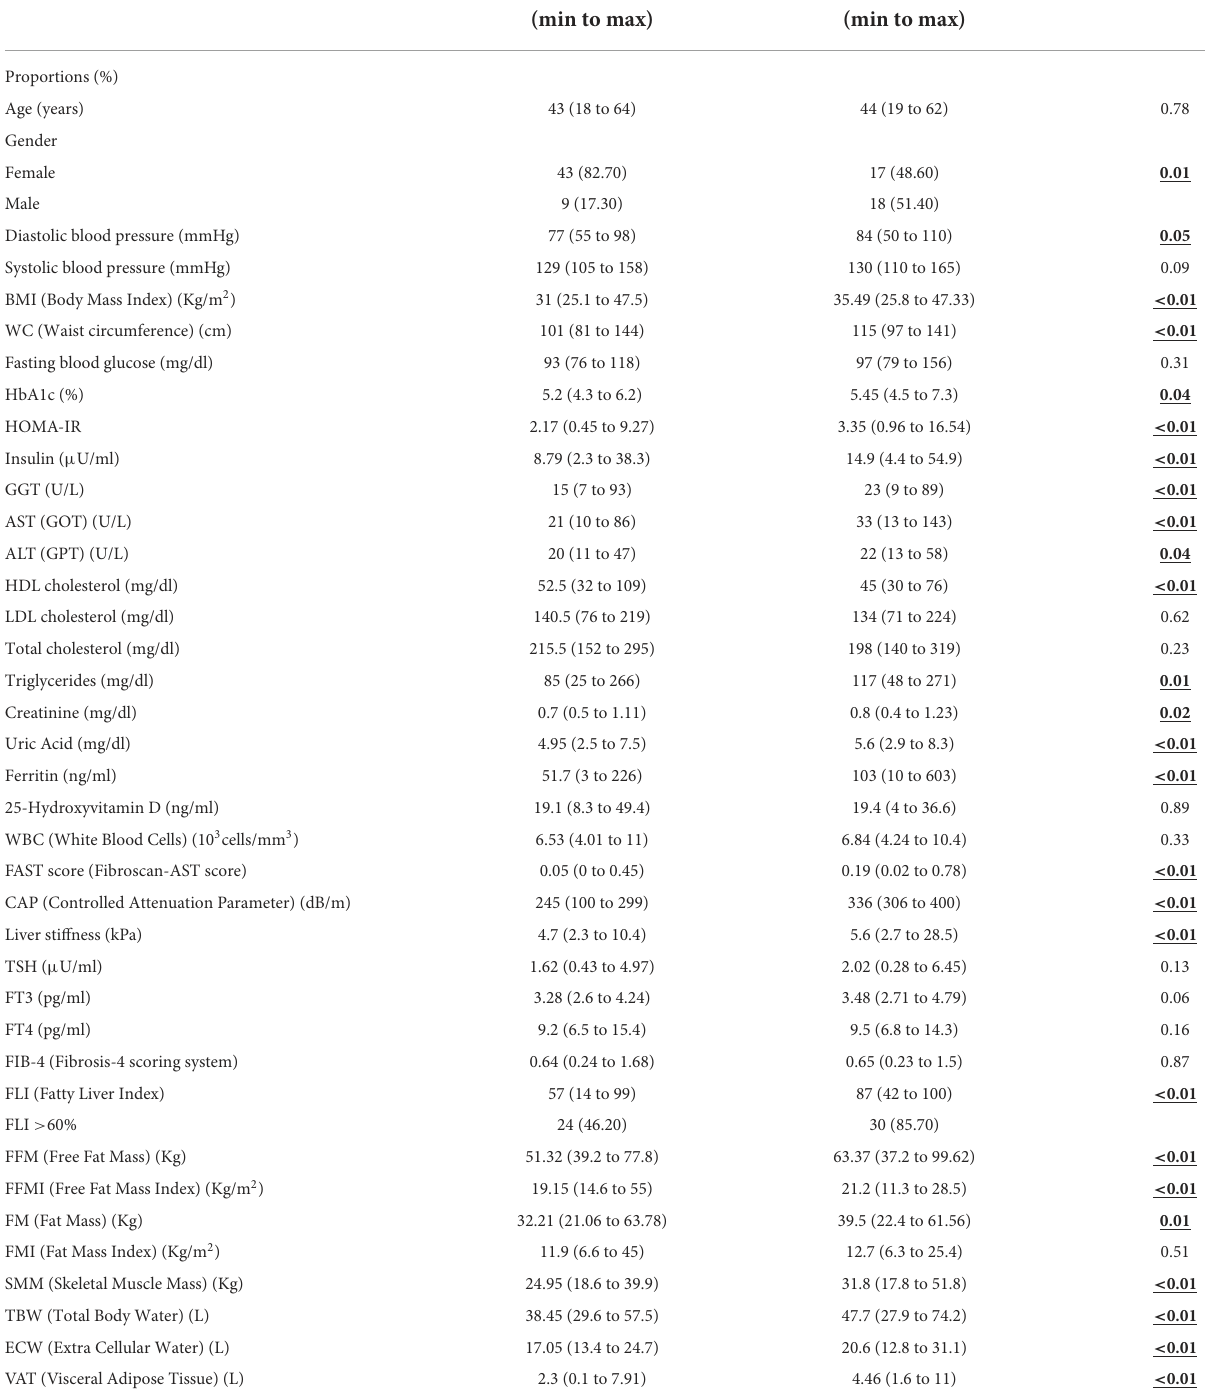
TABLE 1 Description of the whole sample according to the Controlled Attenuation Parameter (CAP) level (CAP < 302 dB/m/CAP ≥ 302